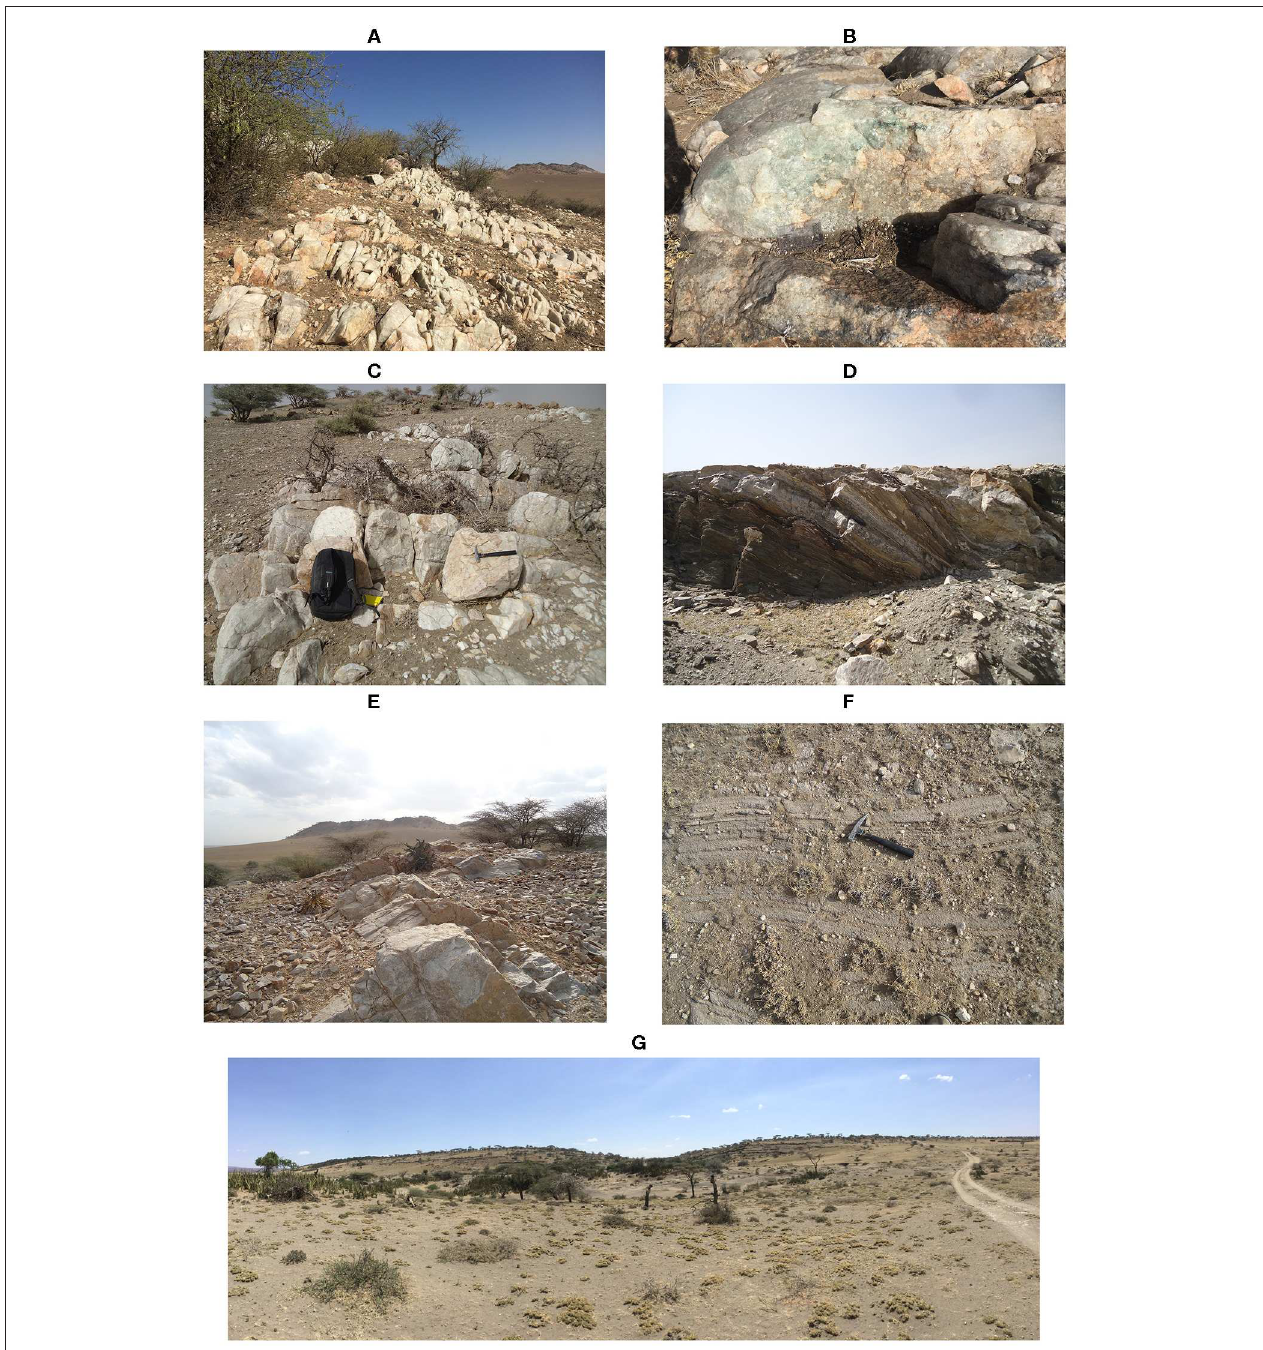
FIGURE 7 | Naibor Soit Ndogo: (A) View west toward Naibor Soit Kubwa showing quartzite foliation planes steeply dipping south; (B) fuchsite-bearing quartzite on the southern side of the inselberg; Naisiusiu: (C) quartzitic (foreground) and meta-granitic (background) lithologies on the northern side of the outcrop; (D) mica schist overlain by quartzite with foliation planes dipping southeast; Oittii: (E) view west toward Naibor Soit Kubwa showing quartzite foliation planes dipping north; (F) east-west trending steeply dipping mica schist with harmonic folding; Olbalbal: (G) panoramic view northwest toward Oldupai Gorge’s First Fault. One sample of medium- to fine-grained mica schist hornblende in one sample of medium- to fine-grained meta- contains muscovite, quartz, biotite, and plagioclase ( Table 2 ). syeno-granite with a hypidiomorphic texture ( Table 2 ). Quartz The texture is primarily lepidoblastic but partly decussate. crystals are anhedral and show undulatory extinction. Opaque Muscovite crystals are responsible for the foliated crystals are responsible for this rock’s spotted texture.